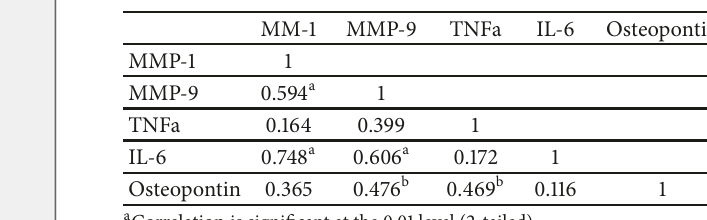
Table 2: Pearson correlation coefficient values between the biomarkers.